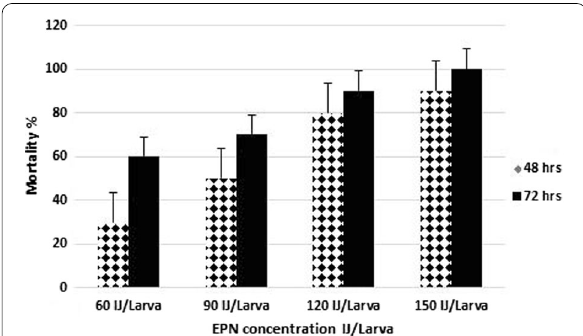
Fig. 2 Mortality of Spodoptera littoralis larvae after treatment with Heterorhabditis taysearae at concentrations of 60, 90, 120 and 150 IJs/ larva after 48 and 72 h post-treatment